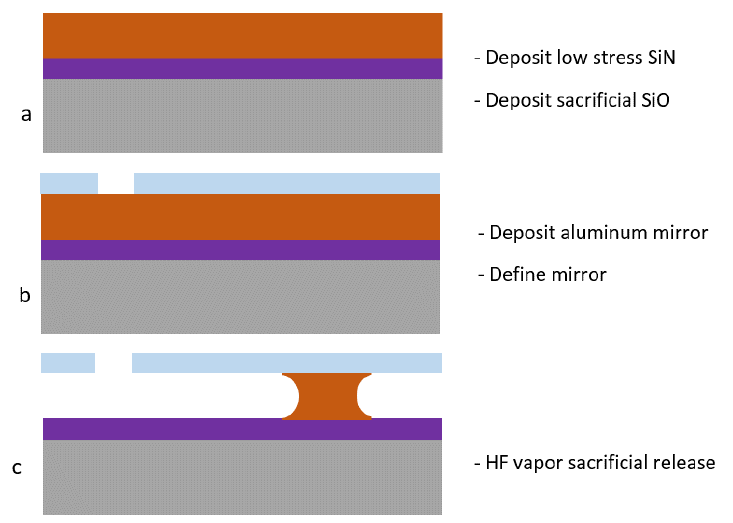
Figure 2. MEMS mirror fabrication sequence. Deposition of low stress silicon nitride and sacrificial silicon oxide ( a ), deposition and patterning of the mirror aluminum film ( b ), HF sacrificial silicon oxide removal to release the suspended structure ( c ).